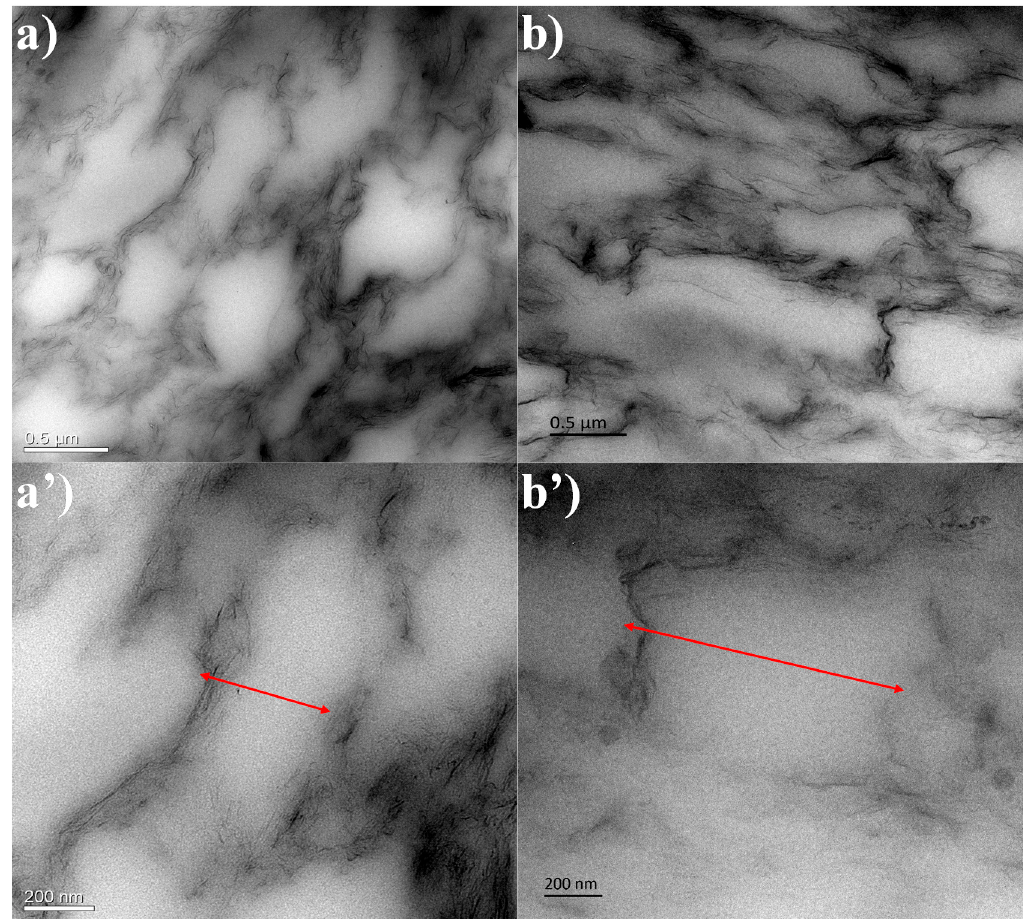
Figure 7. The TEM images of the GNR-6 composites before ( a , a’ ) and after ( b , b’ ) the rubber permanent deformation with 100% strain (15 mm stretched length).